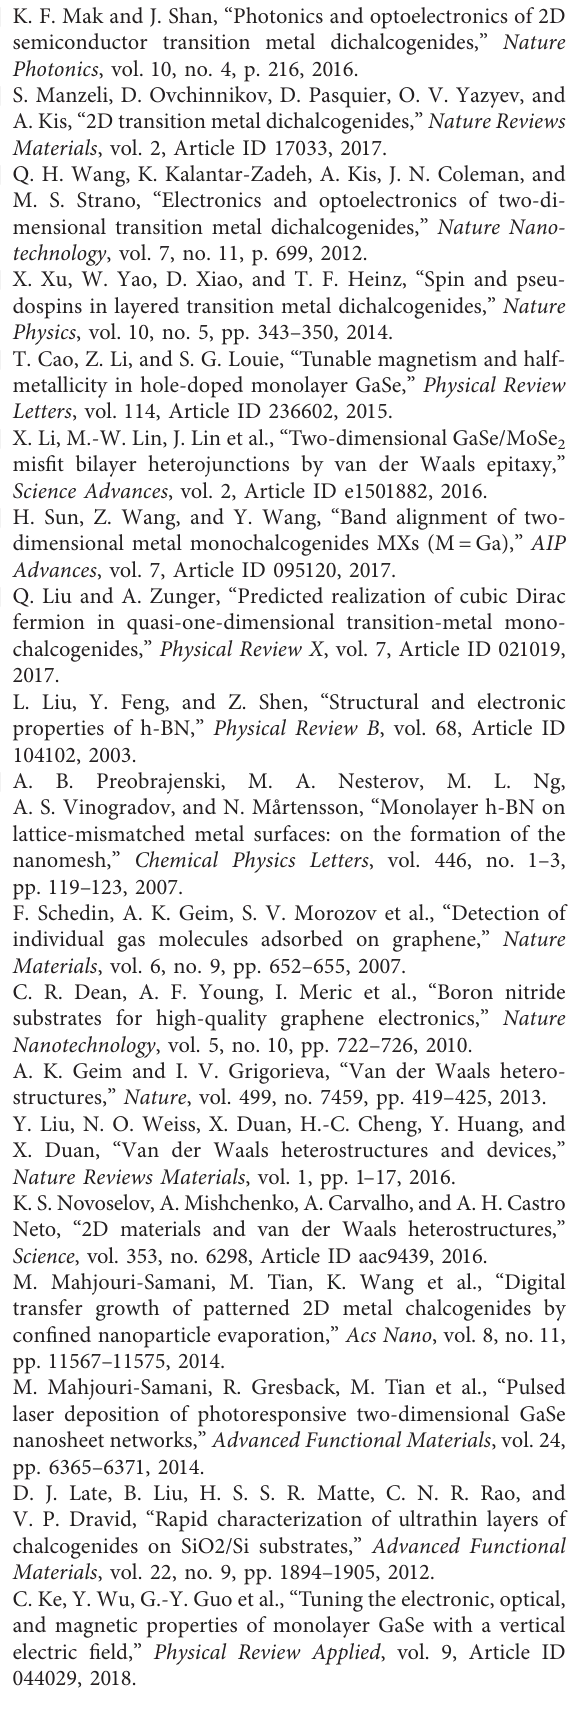
Figure 1S: band structures of the GaSe/SiH vdW hetero- structure under applied electric fields with steps of 0.1 V/˚A. The upper levels from left to right are − 1 to − 0.1 V/˚A, while the lower levels from left to right are 0.1 to 1 V/˚A. The blue lines represent the GaSe, while the red lines represent the SiH. Figure 2S: band structures of the GaSe/SiH vdW het- erostructure under inplane biaxial strains with steps of 1%; from left to right, the strains are − 5% to 5%. The blue lines represent the GaSe, while the red lines represent the